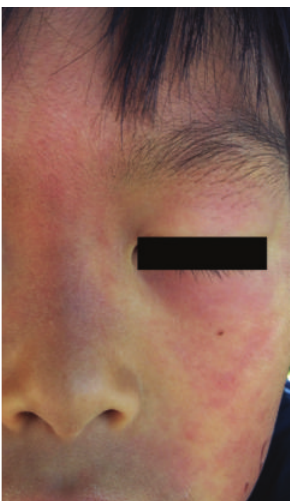
Figure 2: Patchy multiple erythemas on the face of case 2